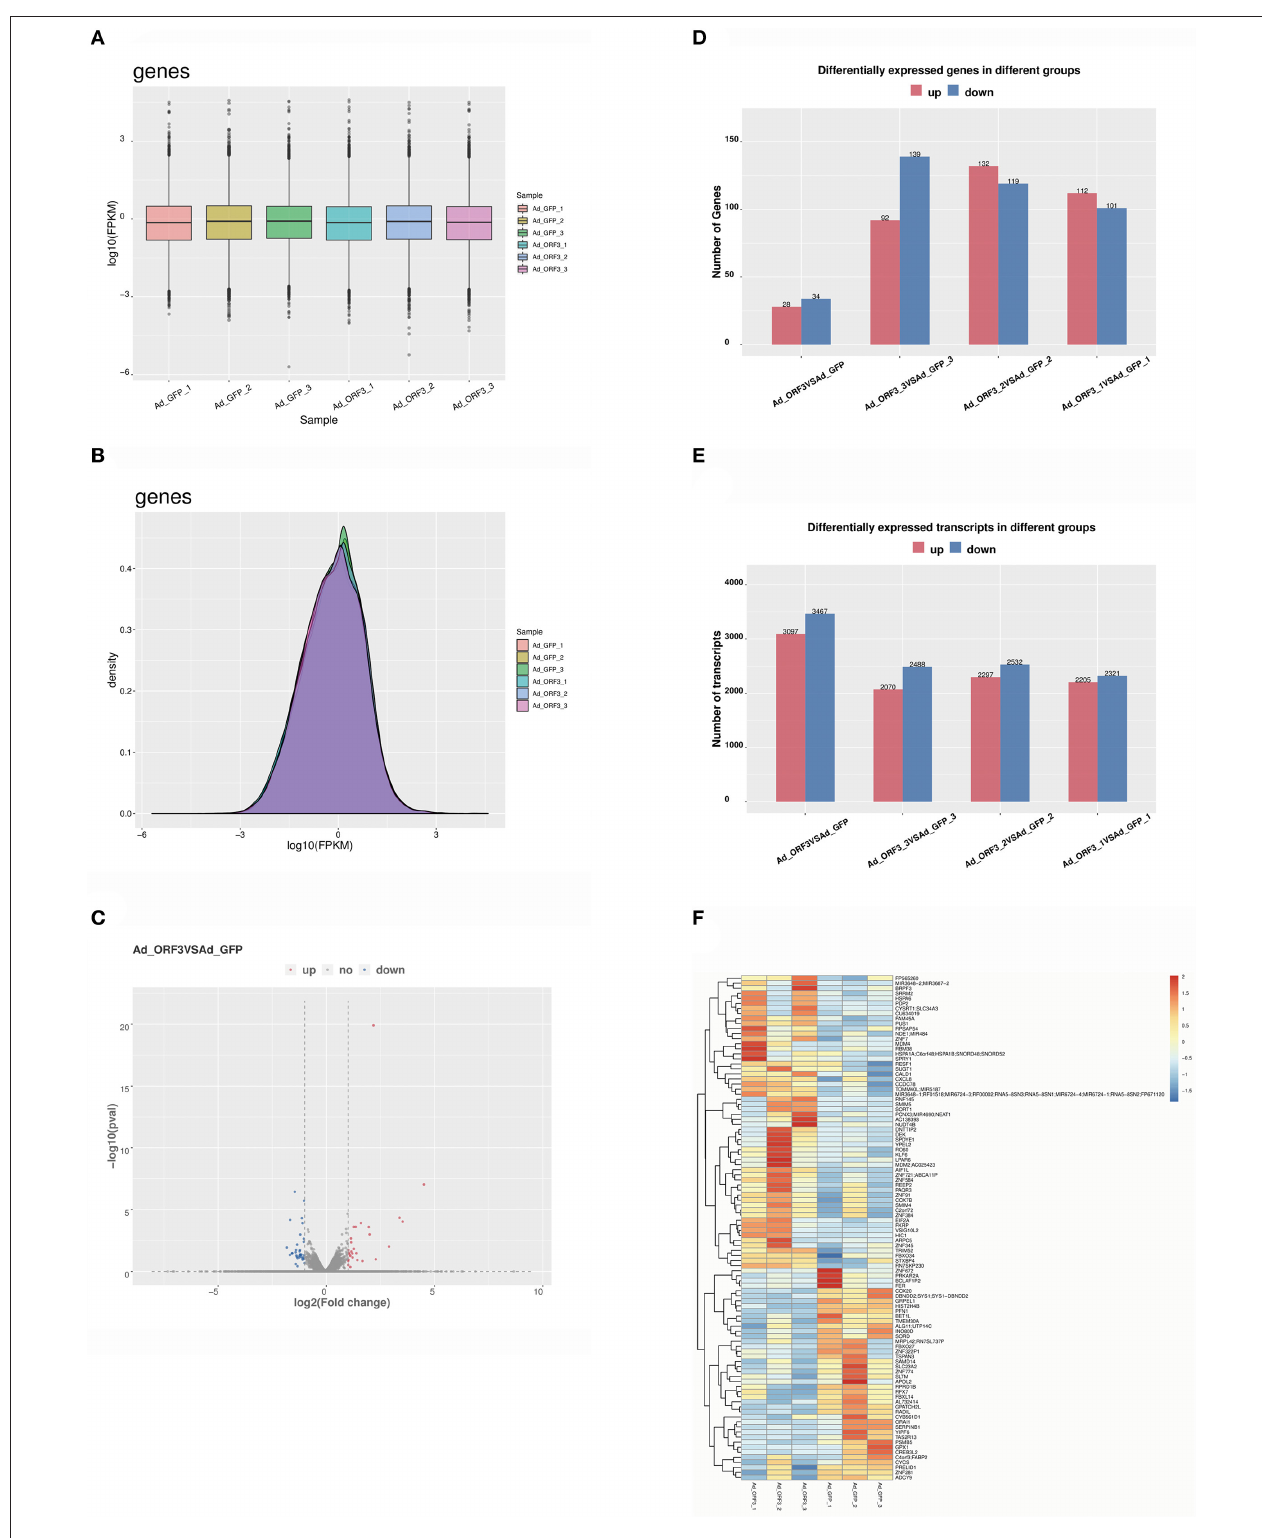
FIGURE 2 | Analysis of DEGs and transcripts. (A) Distribution of gene expression values for each sample. The x-axis is the sample name, and the y-axis is log10 (FPKM). The box graph of each region corresponds to five statistics (the maximum, the upper quartile, the median, the lower quartile, and the minimum,